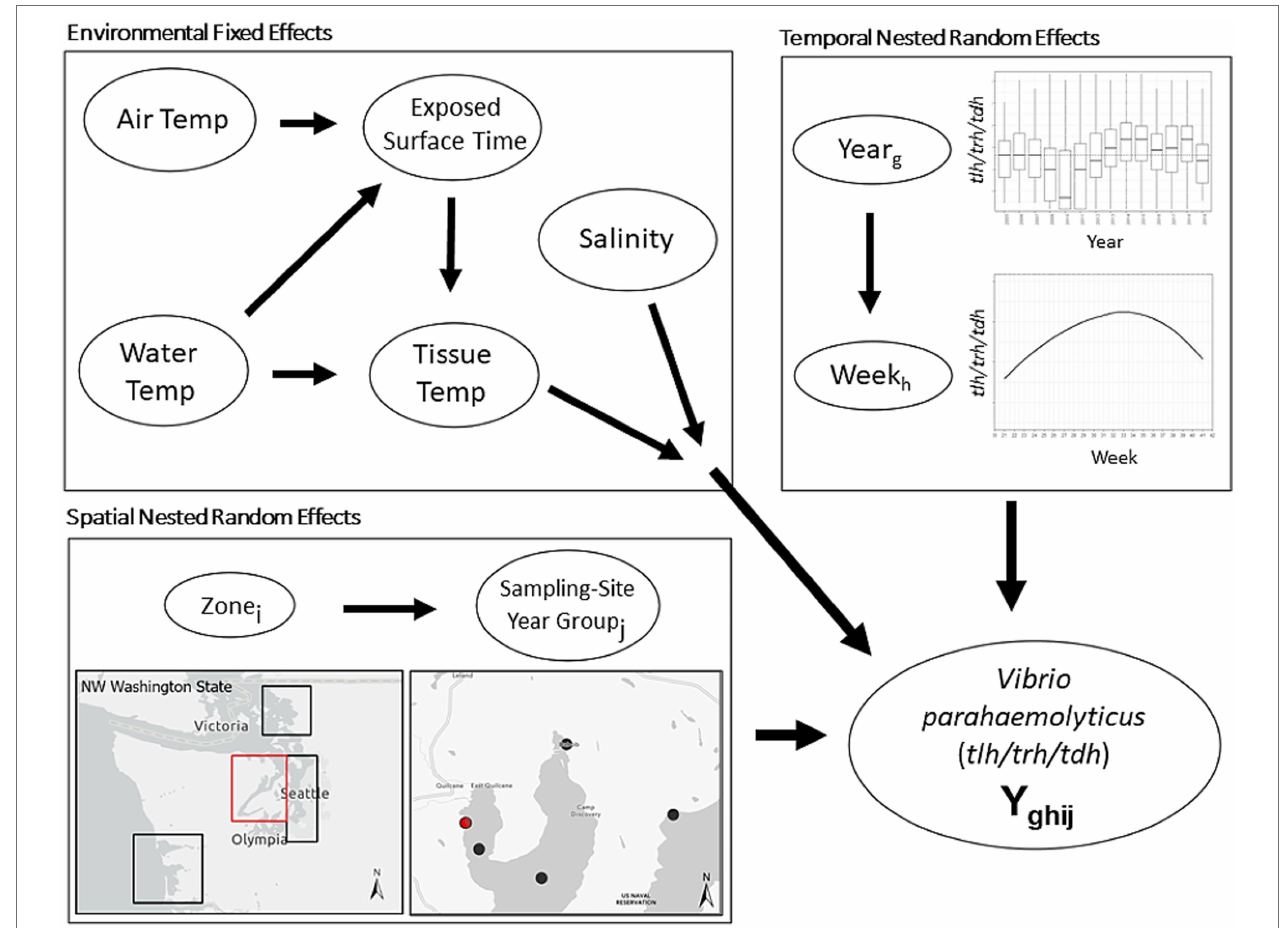
FIGURE 2 | Schematic illustration of base nested model structure. First level environmental conditions fixed effects are modified by higher level spatial and temporal random effects. Spatial random effect of Sample-Site-Year-Group (SSYG; j ) is nested within effect of oyster growing zone ( i ) in Washington state. Temporal random effect of sampling week ( h ) is nested within random effect of year ( g ). Spatial and temporal model levels modify relationship between environmental conditions and concentrations of Vibrio parahaemolyticus genetic markers ( tlh or trh or tdh or ratio of two markers, etc.) in the model. Water Temp consisted of two measurements (surface water temperature and shore water